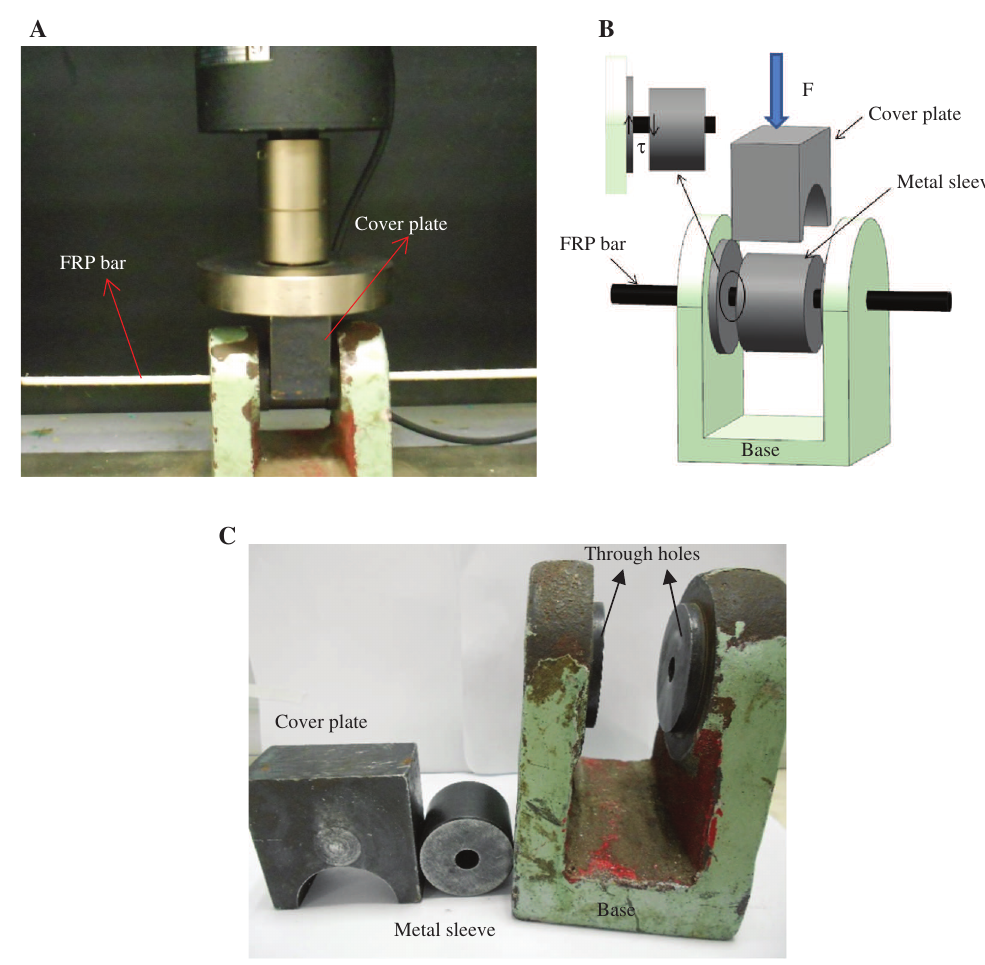
Figure 5: Shear test equipment: (A) photograph; (B) schematic sketch; (C) components. cycling corrosion were conducted at 55°C. Based on